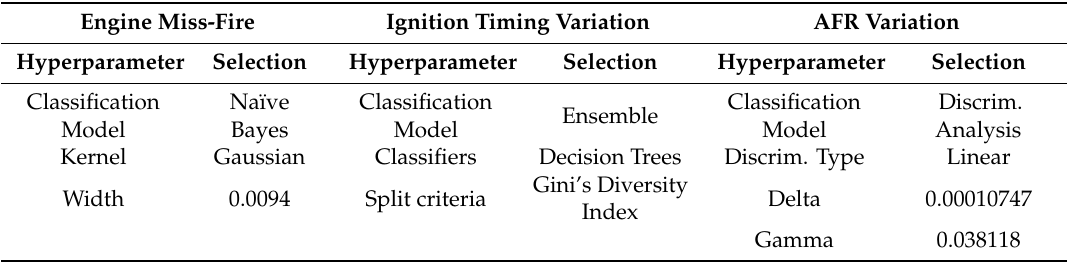
Table 5. Optimal parameters for Model 2—using Bayesian